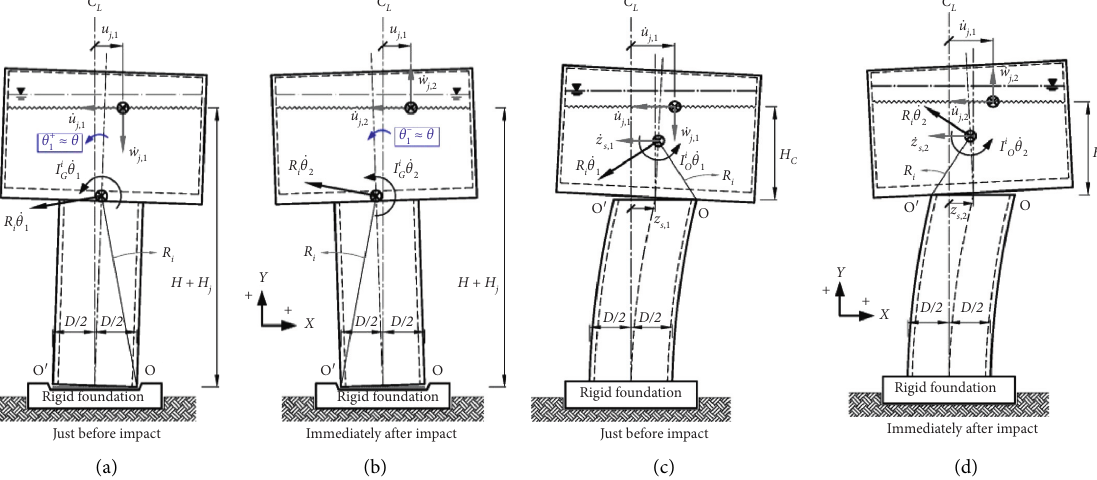
Figure 6: Configuration of the rocking elevated tanks with (right) C1 and (left) C2: (a, c) just before and (b, d) immediately after the impact at the left corner (O ′